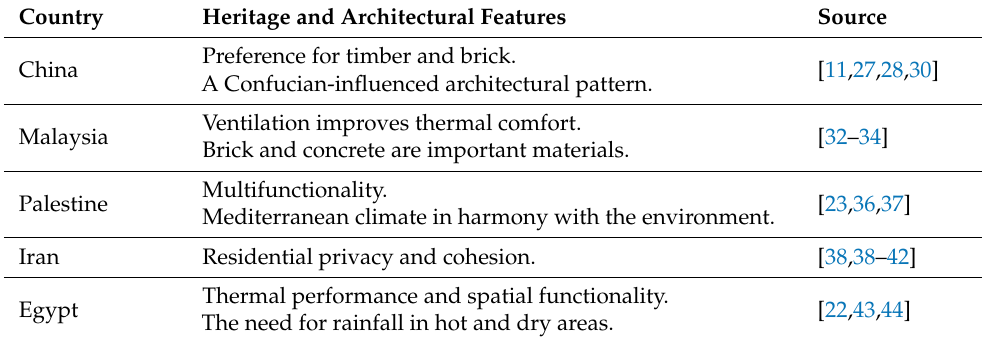
Table 2. Heritage and architectural